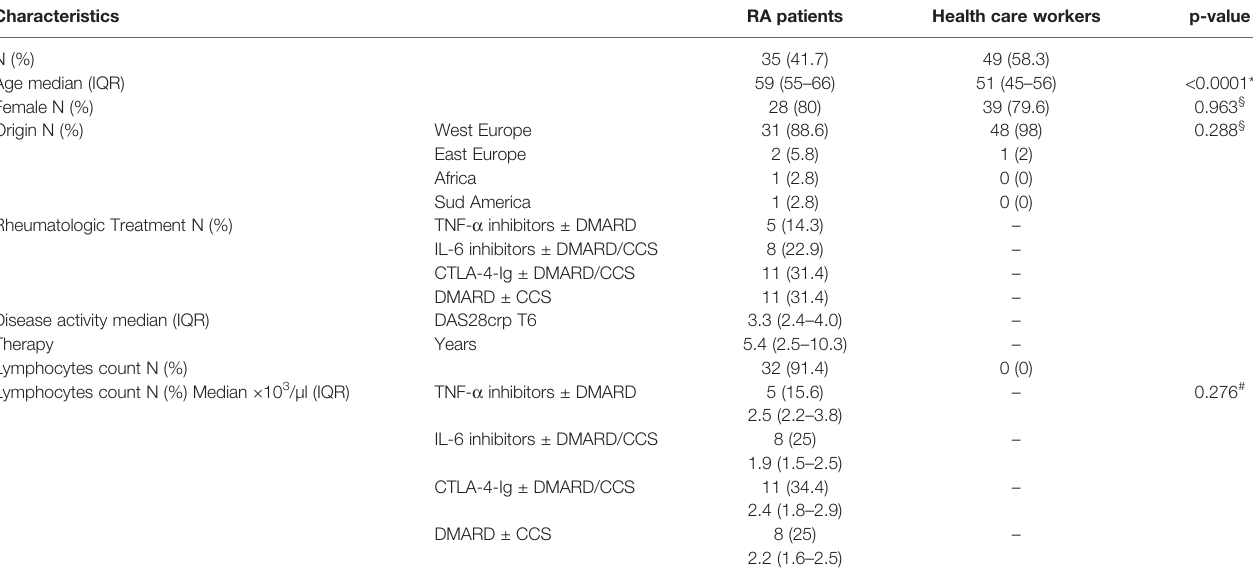
TABLE 1 | Demographical and clinical characteristics of the 84 enrolled subjects at T6.